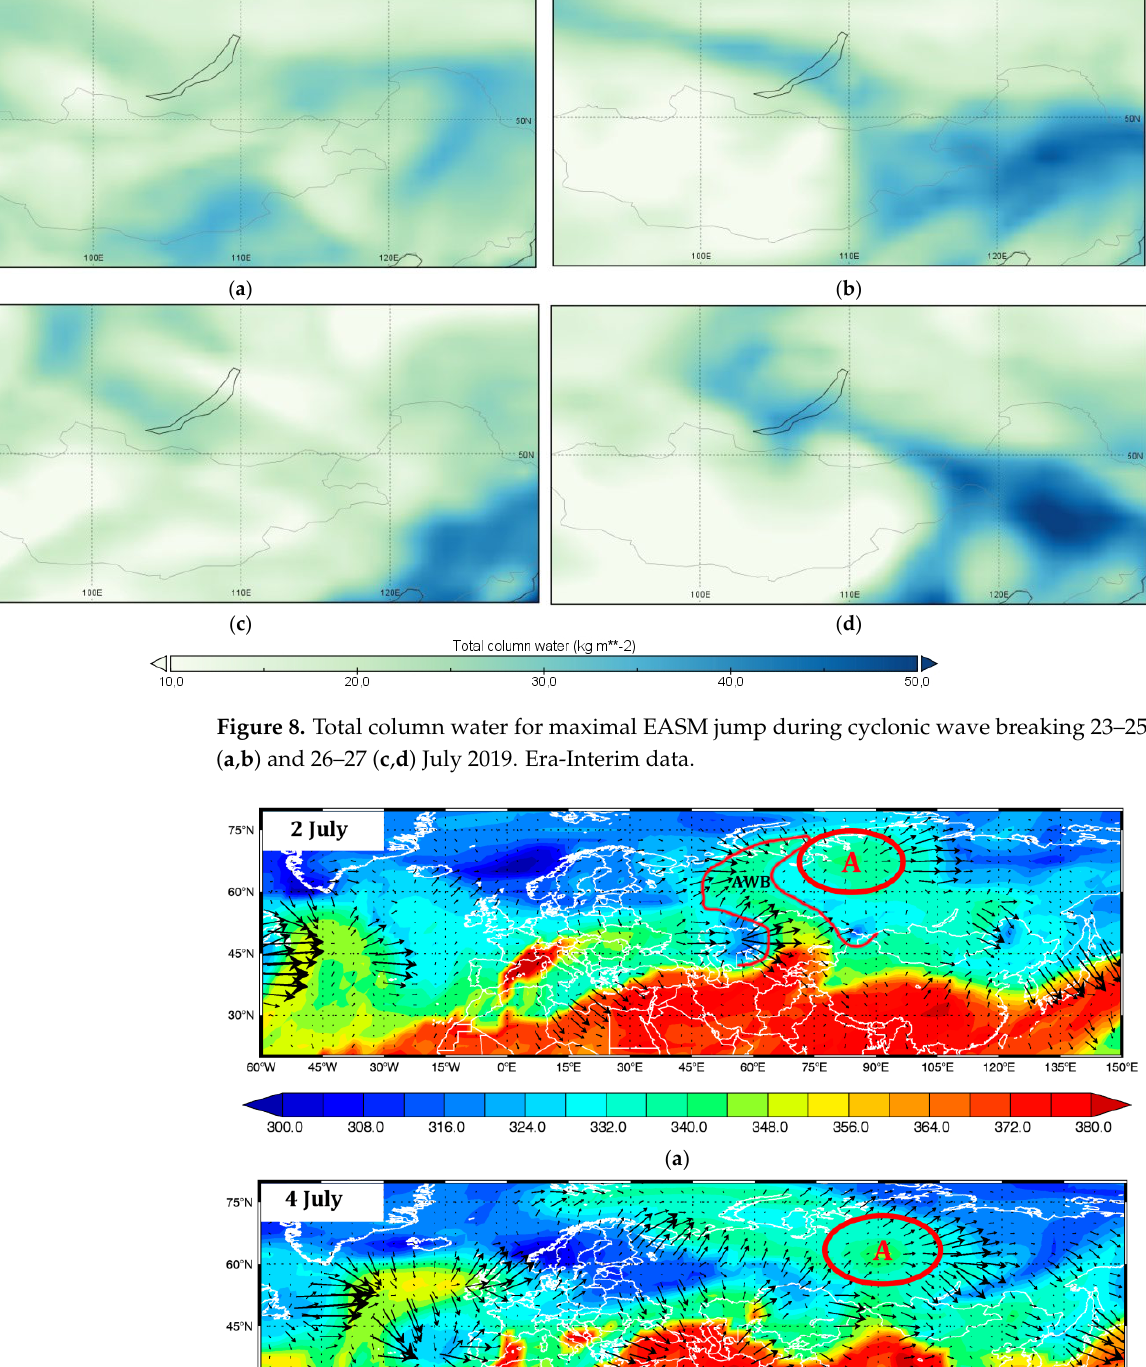
Figure 7. Cross-sections of horizontal wind speed (m/s) (blue and red fill), PV (PVU) (black lines) and vertical speed (Pa/s) (red and blue dashed lines) for 24 June 18 UTC ( а ), 25 June 12 UTC ( b ) and 27 July 12 UTC ( c ), letters A and B in Figure 6. The negative value for vertical velocity—ascending motions. Red shading—westerly wind (positive); blue—easterly wind (negative). Era-Interim data.